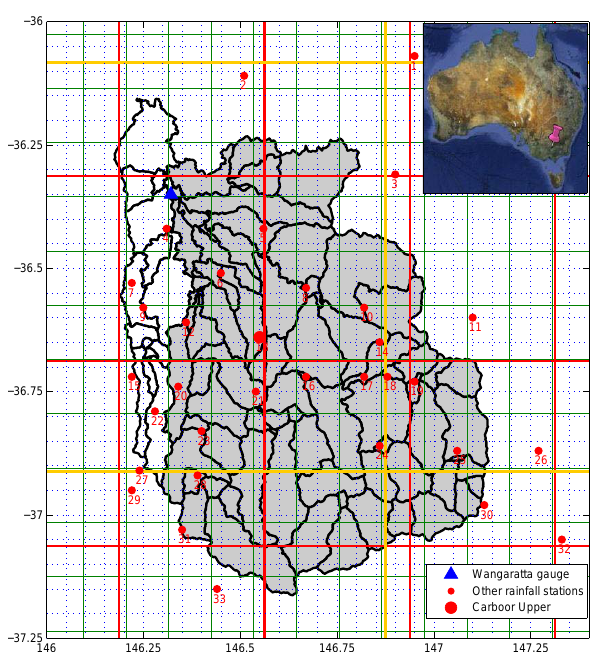
Fig. 3. Map of the Ovens catchment with sub-catchment delin- eation, precipitation and streamflow gauges. The shown are the overlaying with the ACCESS model grids – dashed, ACCESS- VT (5km); thin line, ACCESS-A (12km); thick line, ACCESS-R (37.5km); and the thickest line; ACCESS-G (80km). The shaded region is the catchment area draining to Wangaratta gauging